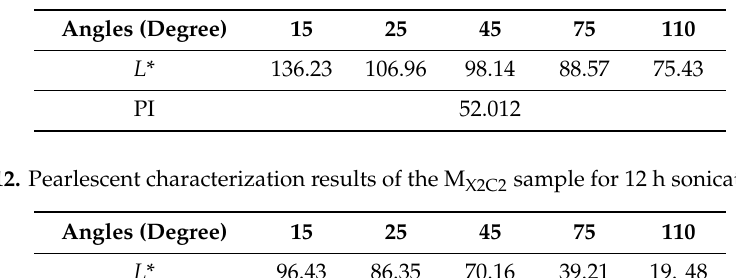
Table 11. Pearlescent characterization results of the M X2C2 sample for 9 h sonication time.